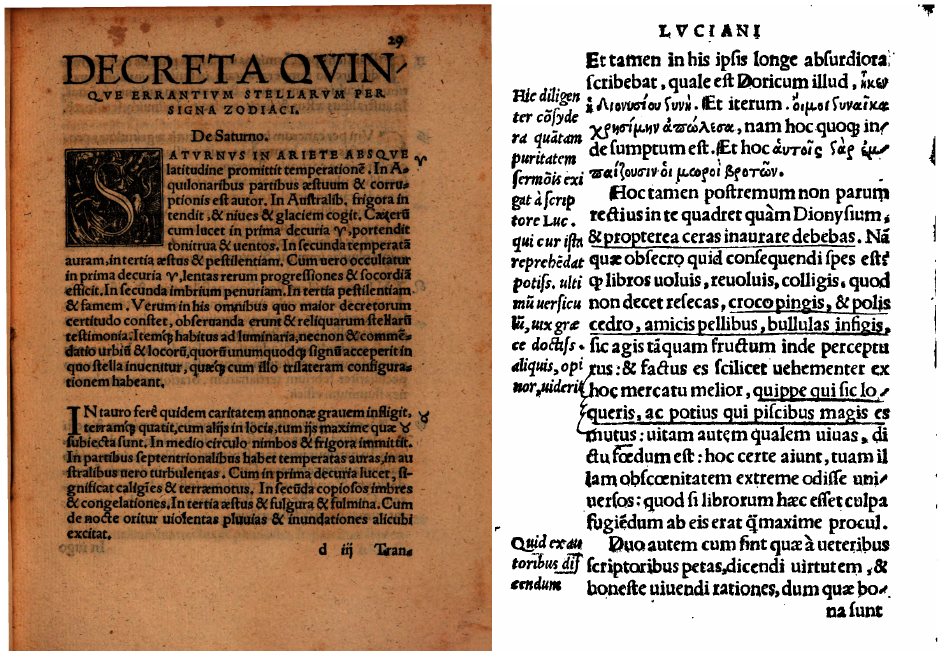
Figure 2. Example images from the CamManual dataset. The left images show difficult dropped capitals, complex footers, and marginalia consisting of single letters representing zodiac signs. The right image shows a page containing handwritten artifacts such as